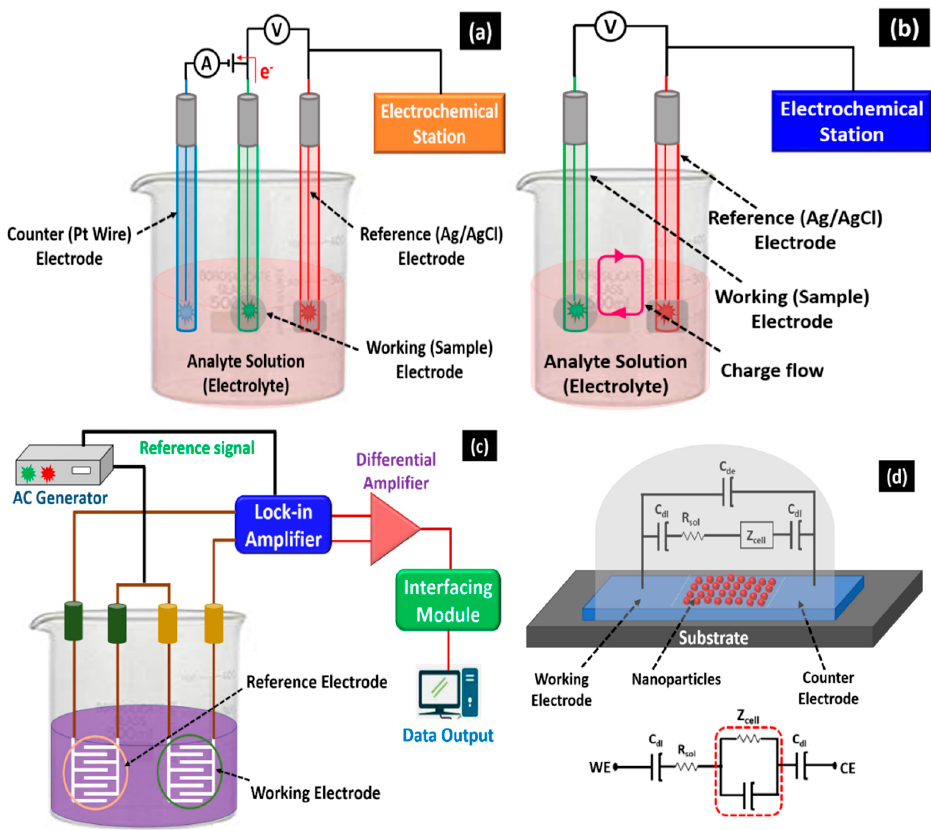
Figure 5. Schematic diagram of ( a ) amperometric/voltammetric, ( b ) potentiometric, and ( c ) conduc- tometric biosensors, and ( d ) equivalent circuit of the impedimetric biosensor. Table 3. Electrochemical biosensors with principles, advantages, and disadvantages.